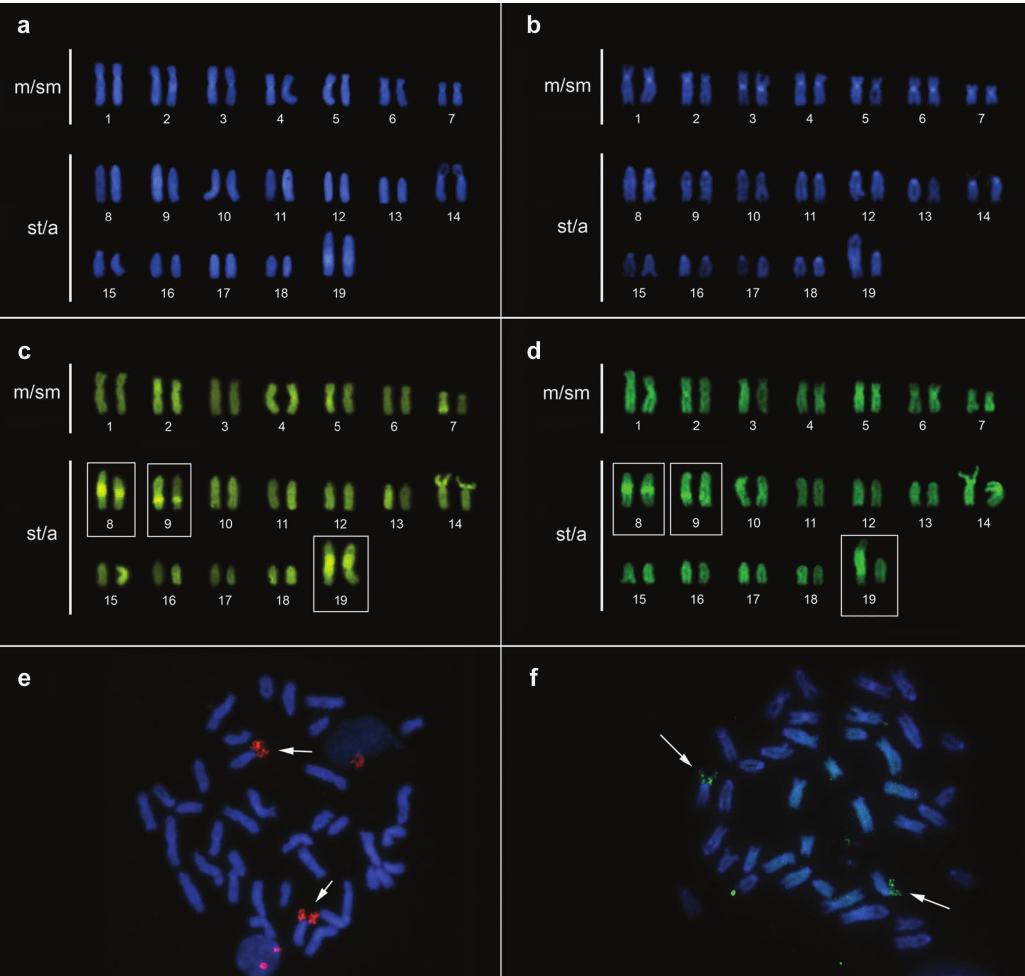
Fig. 8. DAPI fluorescent banding showing centromeric regions of both males (a) and females (b) of Eigenmannia sp. “B”. CMA fluorescent banding hybridizing areas, which coincide with the NOR (Fig. 6) on chromosome 14 of males (c) and 3 females (d), and strong signal on pairs 8, 9 and the X – inset boxes. FISH with 18S rDNA probes of Eigenmannia sp. “B”, hybridizing on the short arm of chromosome 14 (arrows) of males (e,